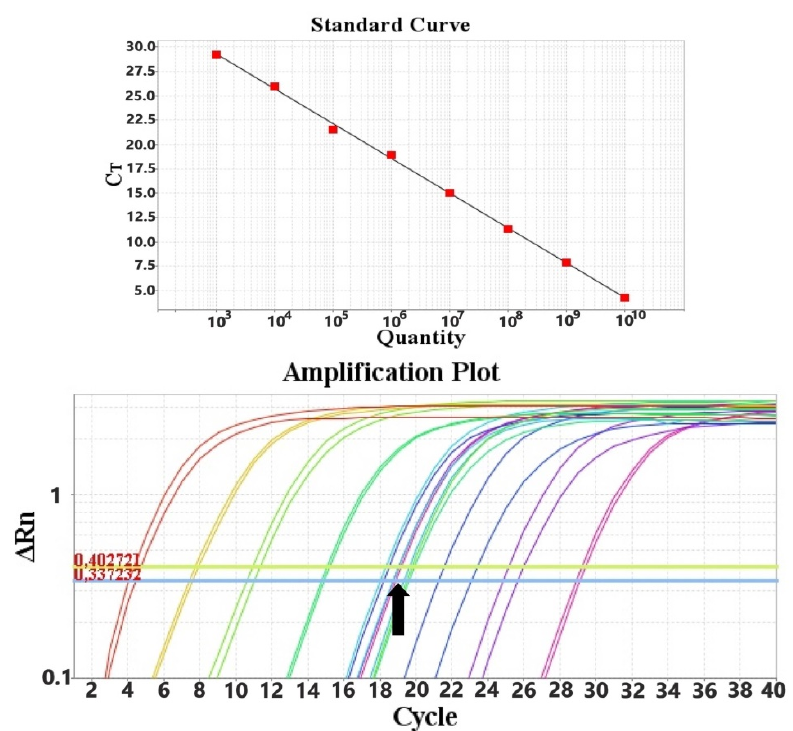
Figure 4. qPCR standard curve using the PPV_Set_1 primer set, which targets the NS1 gene, and the amplification plot with reference and field samples indicated with the black arrow.